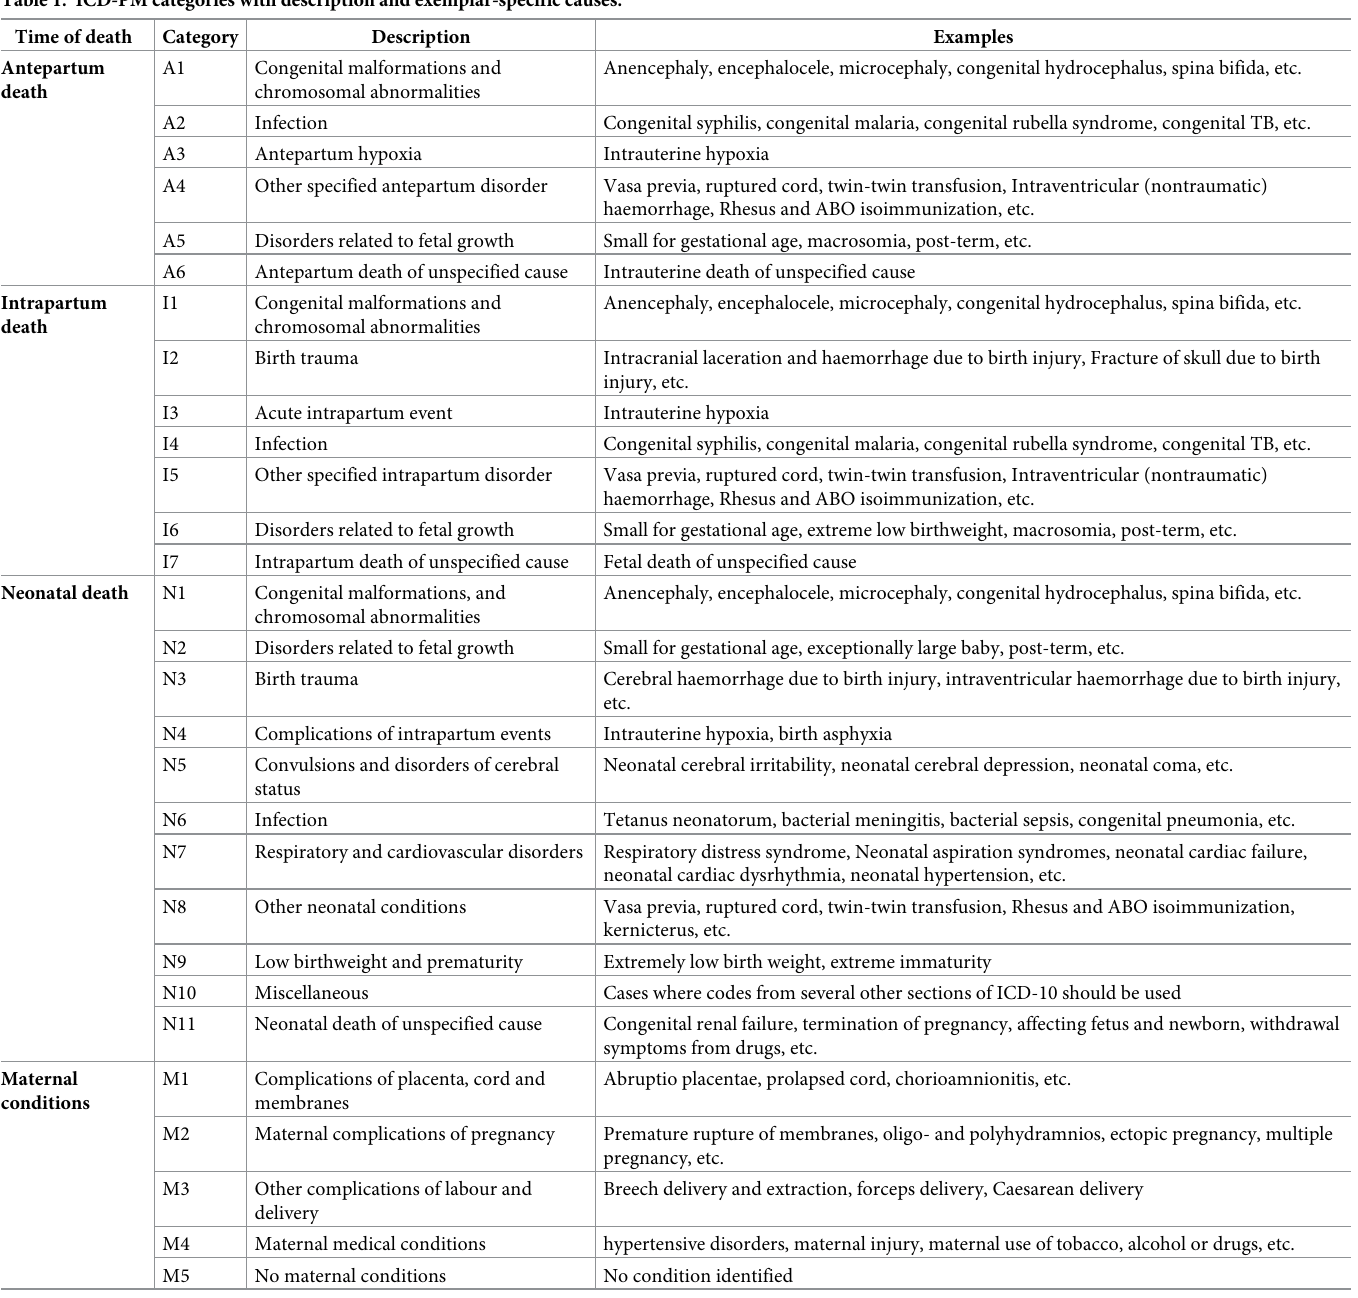
Table 1. ICD-PM categories with description and exemplar-specific causes. Time of